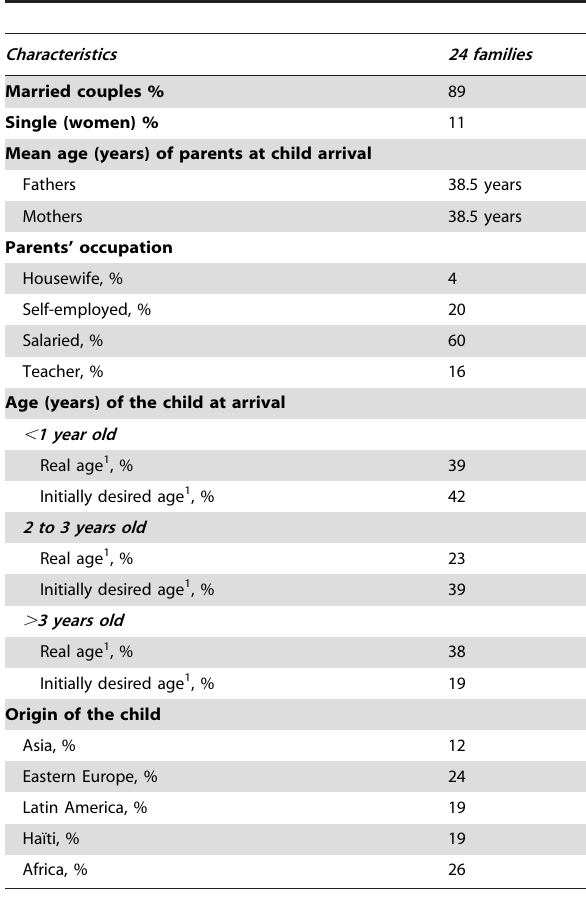
Table 1. Characteristics of the 24 families who agreed to participate in the